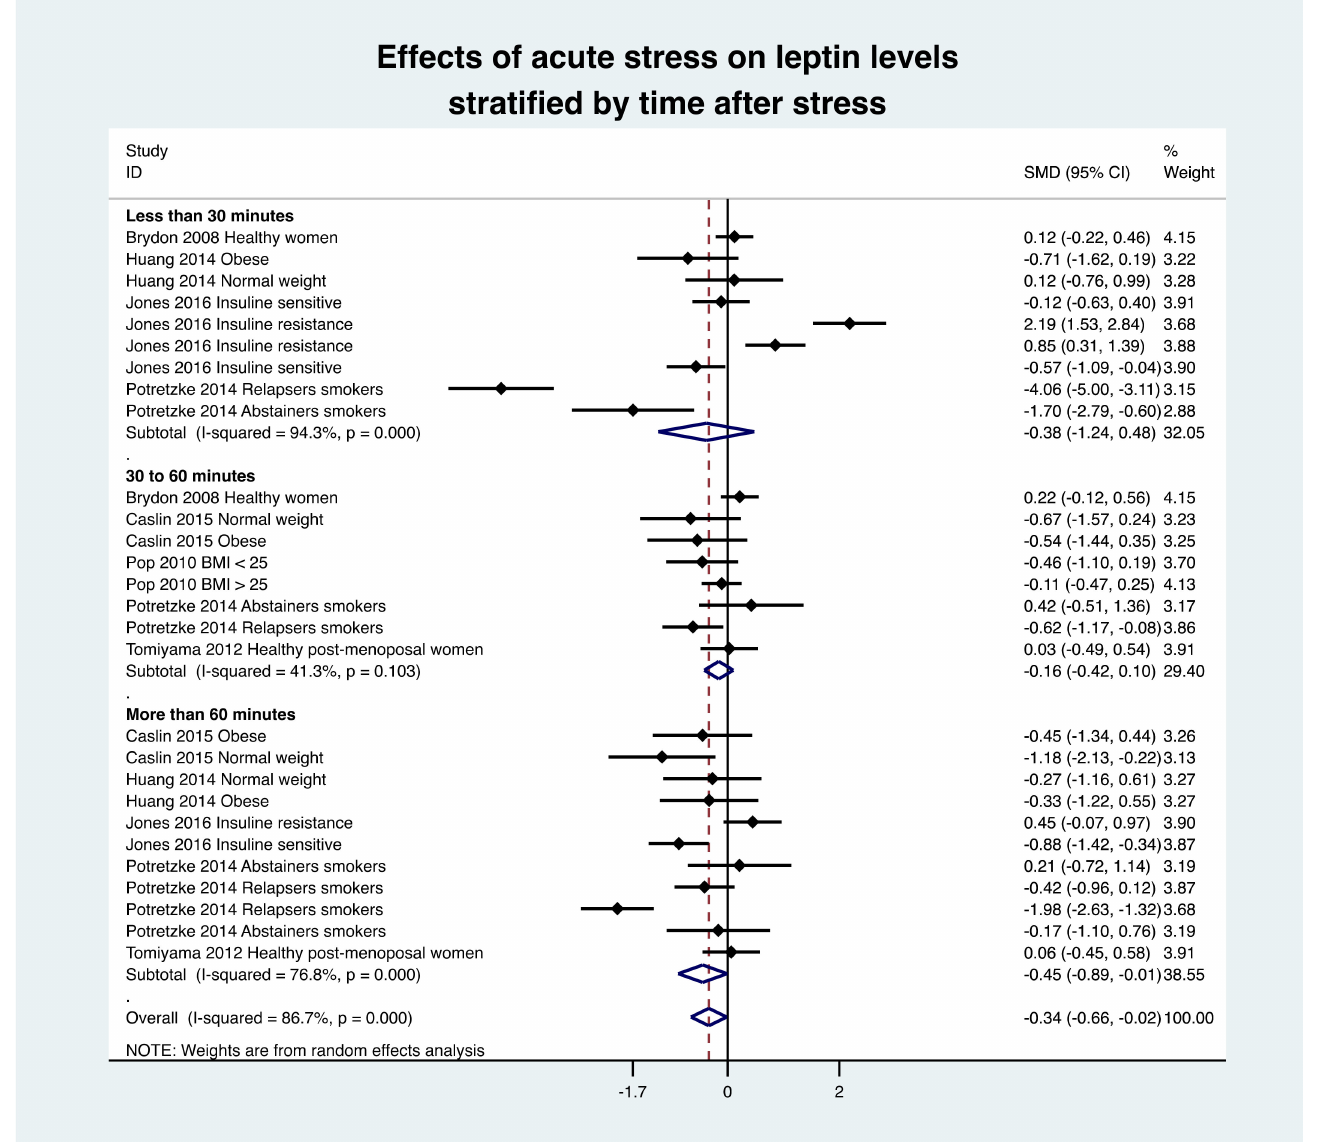
Figure 3. Meta-analysis of leptin levels following acute stress compared to baseline. SMD, standardized mean